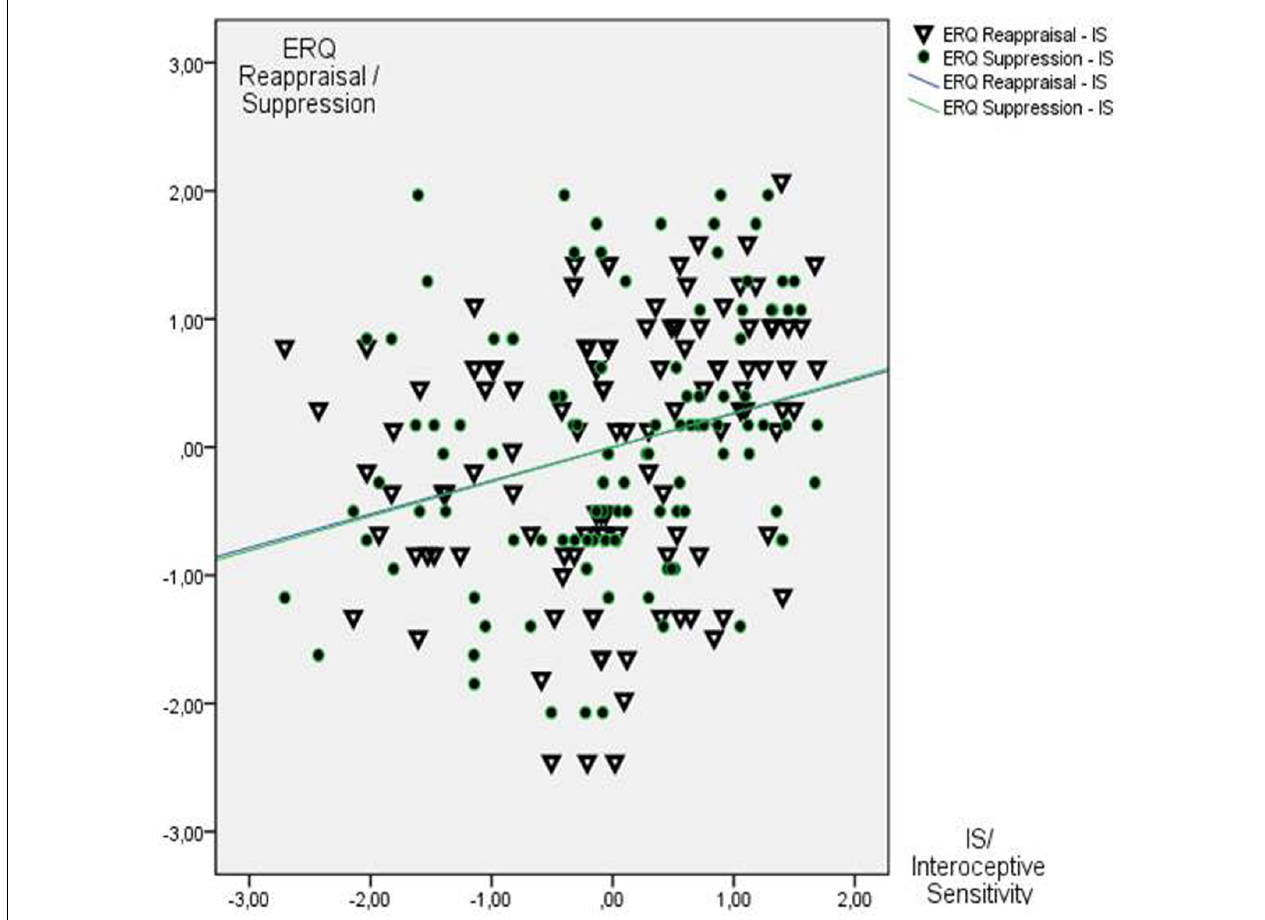
FIGURE 3 | Scatterplot between IS and both reappraisal and suppression ( N = 116; z -scores